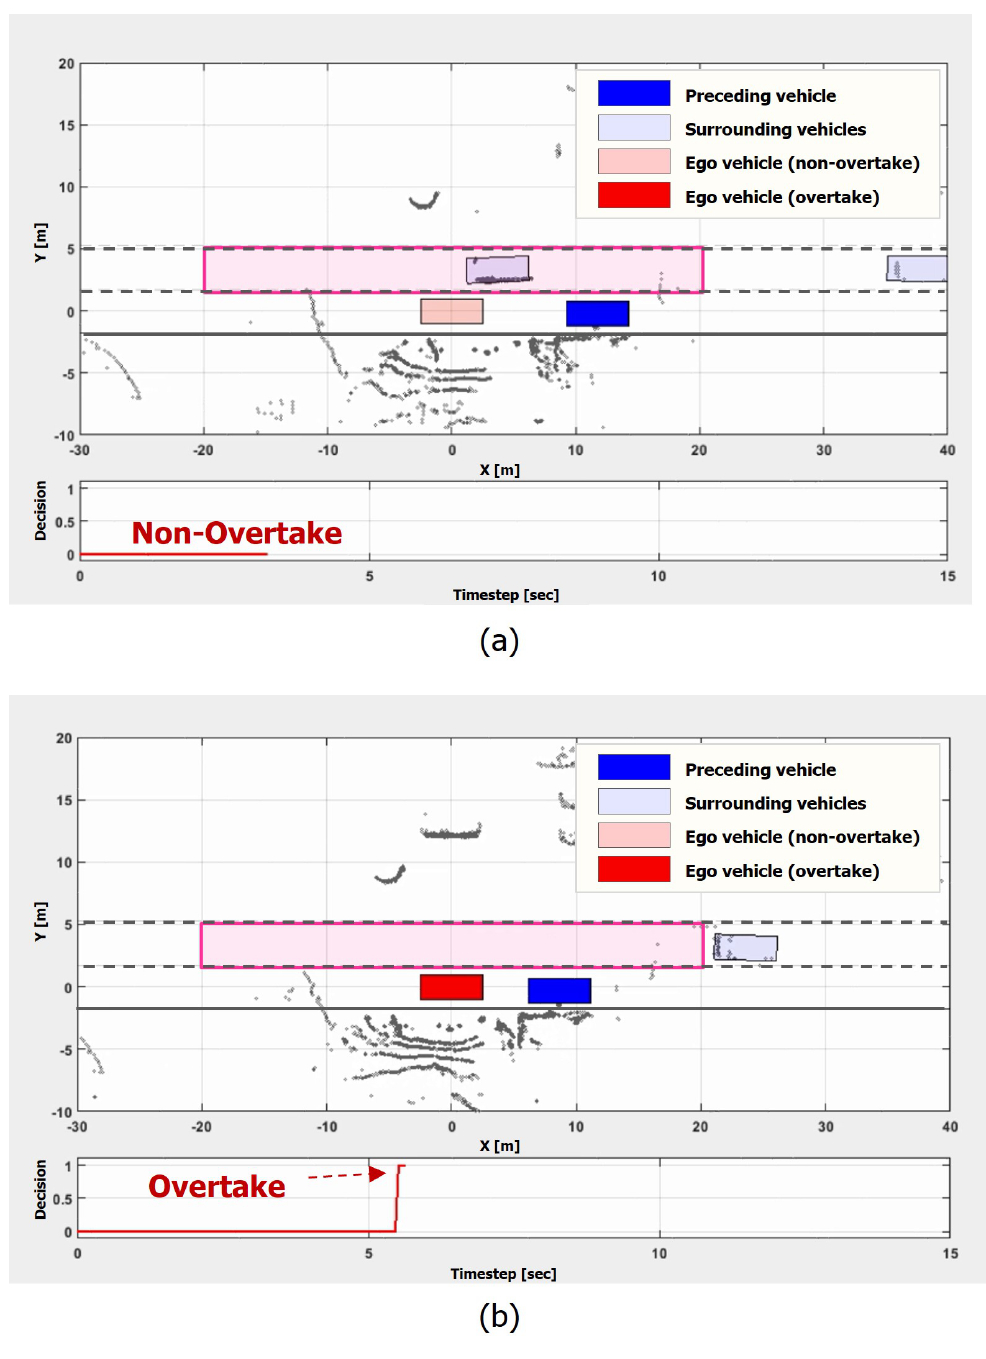
Figure 15. Light traffic scenario. In the scenario, the ego vehicle is behind a stationary preceding vehicle while the vehicles on the left lane are driving at around 30–40 km/h: ( a ) t = 3.5 s; ( b ) t = 5.5